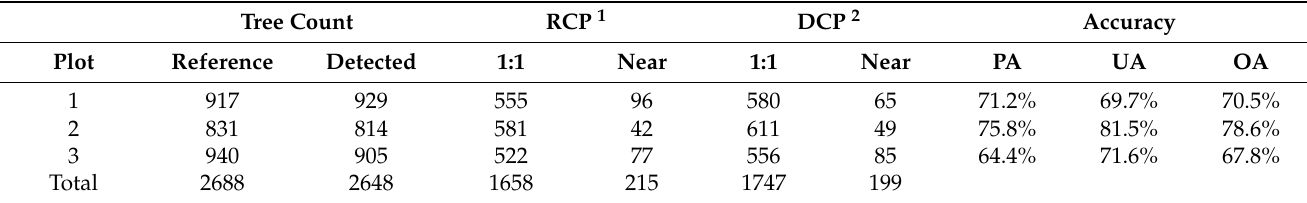
Table 4. Accuracy assessment of individual tree crowns match using the RHCSA method.